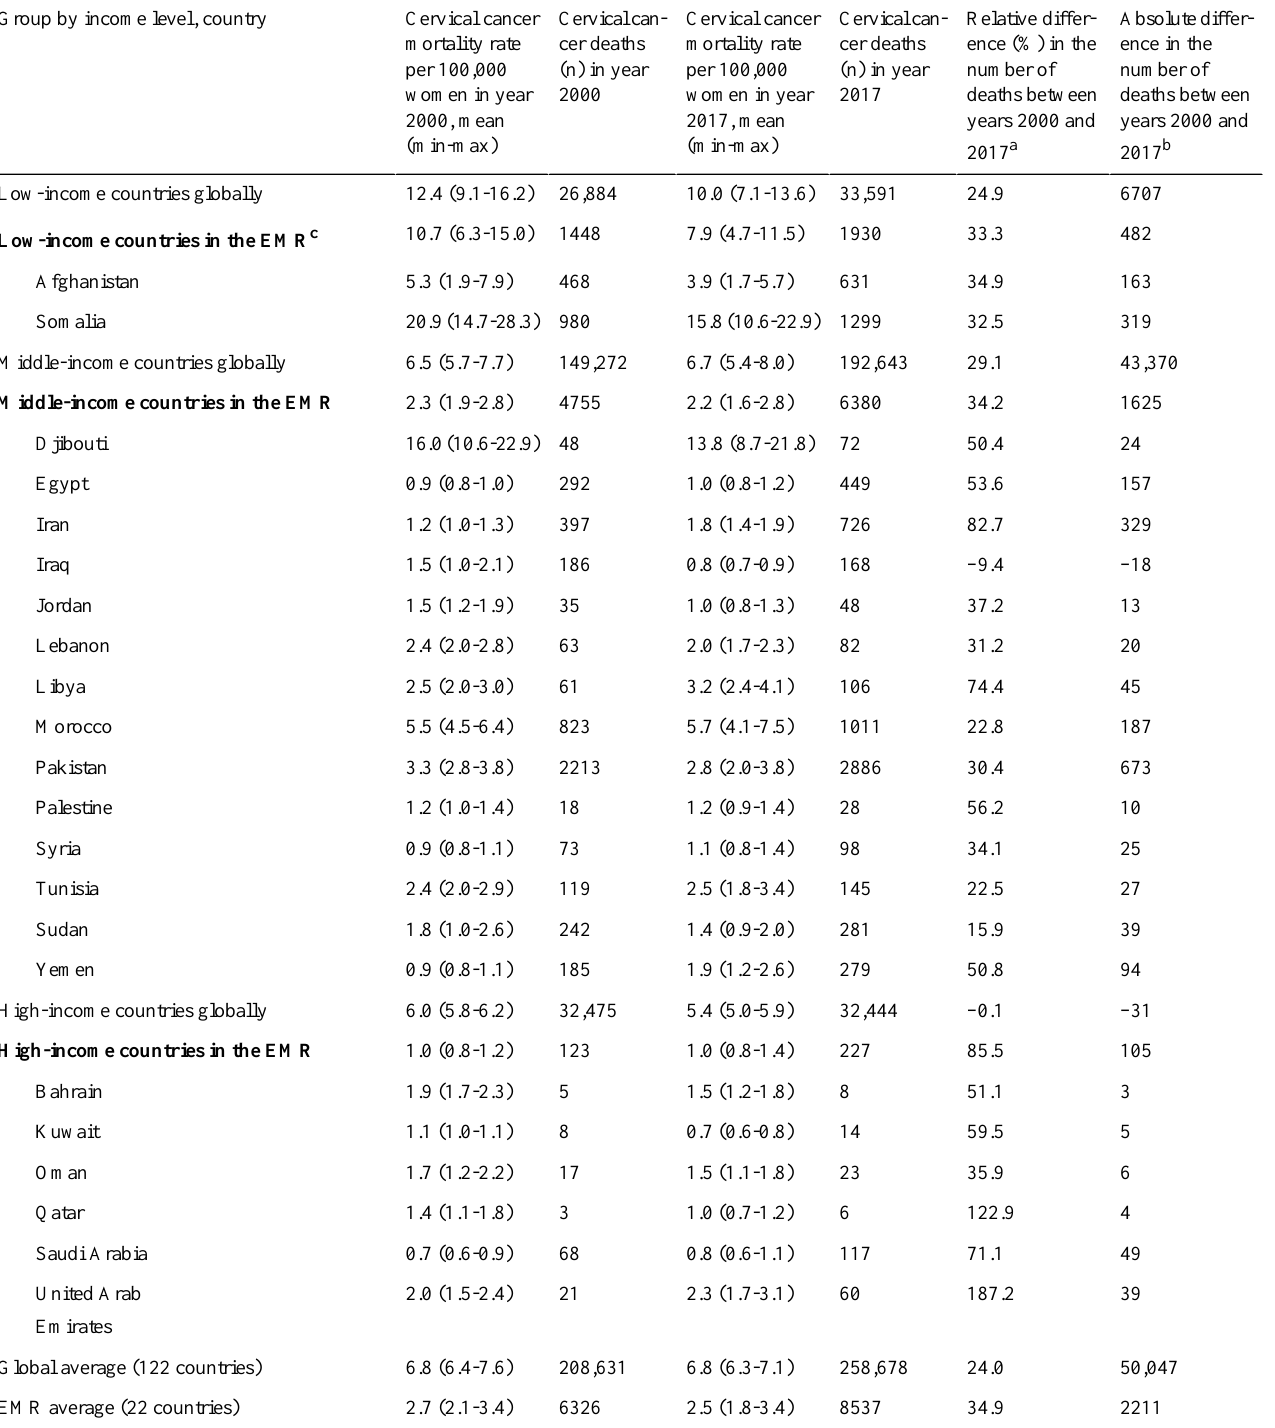
Table 1. Cervical cancer mortality among women older than 20 years in the Eastern Mediterranean Region by country and income level compared to the global average in the years 2000 and 2017. by income level,